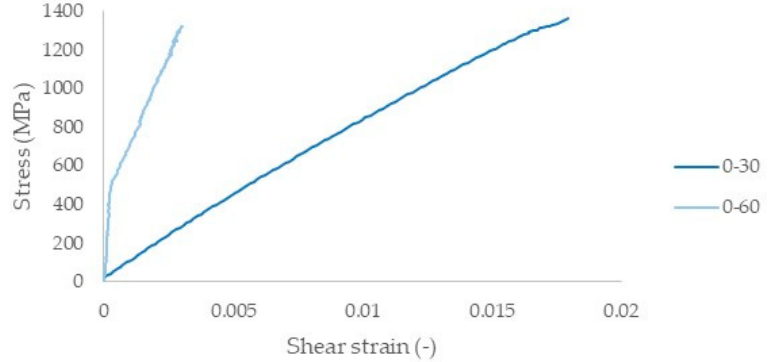
Figure 8. Stress–shear strain curves of the angle-ply Figure 8. Stress – shear strain curves of the angle-ply laminates.